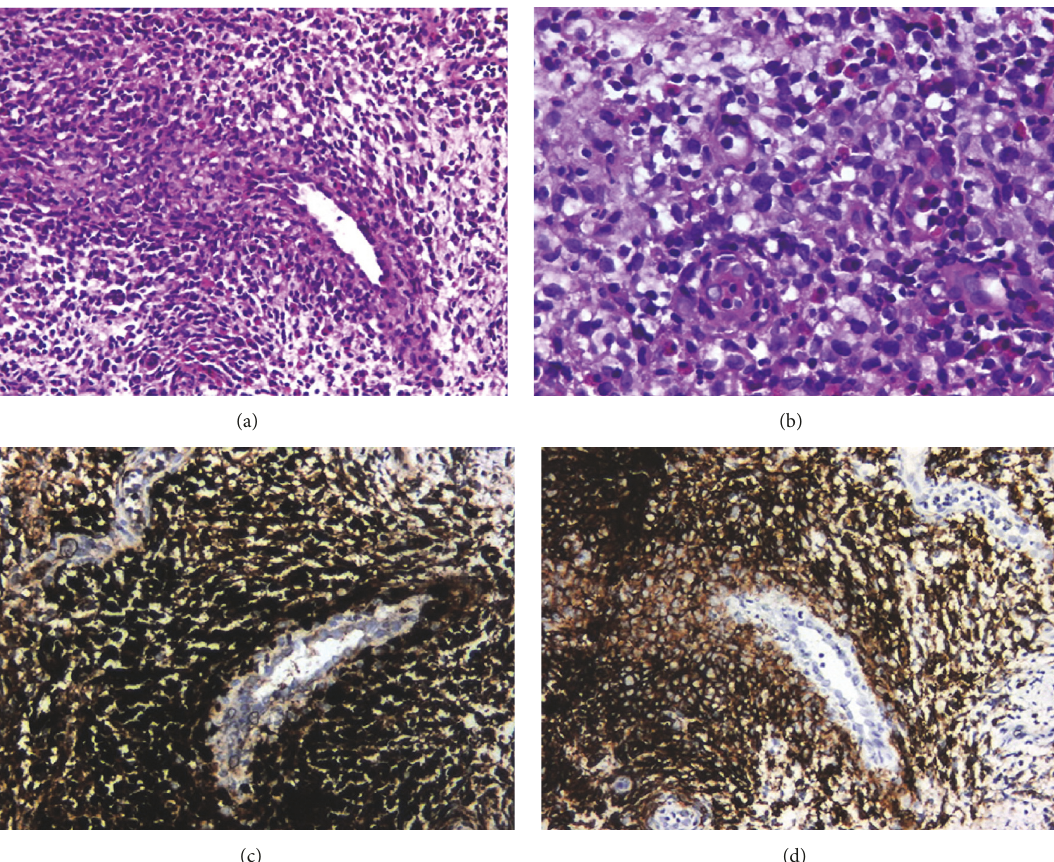
Figure 2: Infiltration of the edematous stroma by polygonal cells with eosinophilic cytoplasm, oval nuclei with longitudinal grooves resembling coffee beans named as Langerhans cells, and eosinophils are observed. (a) Haematoxylin and eosin, × 200 magnification. (b) Haematoxylin and eosin, × 400 magnification. (c) Langerhans cells were highlighted immunohistochemically by S-100, × 200 magnification. (d) Langerhans cells were highlighted immunohistochemically by CD1a, × 200